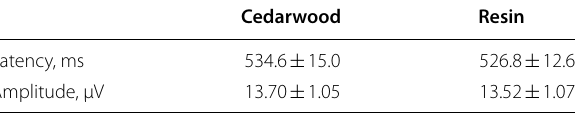
Table 3 P3b latencies and amplitudes in response to the target stimulus under each condition at the Pz electrode (parietal site)